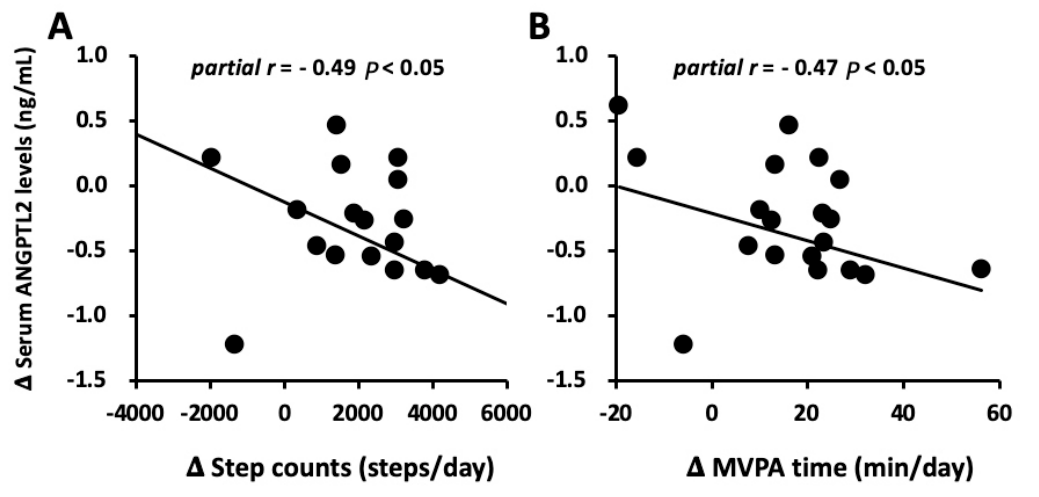
Fig. 3. Association between the changes in serum ANGPTL2 levels and Step counts (A) and MVPA time (B) following a 12-week aerobic exercise